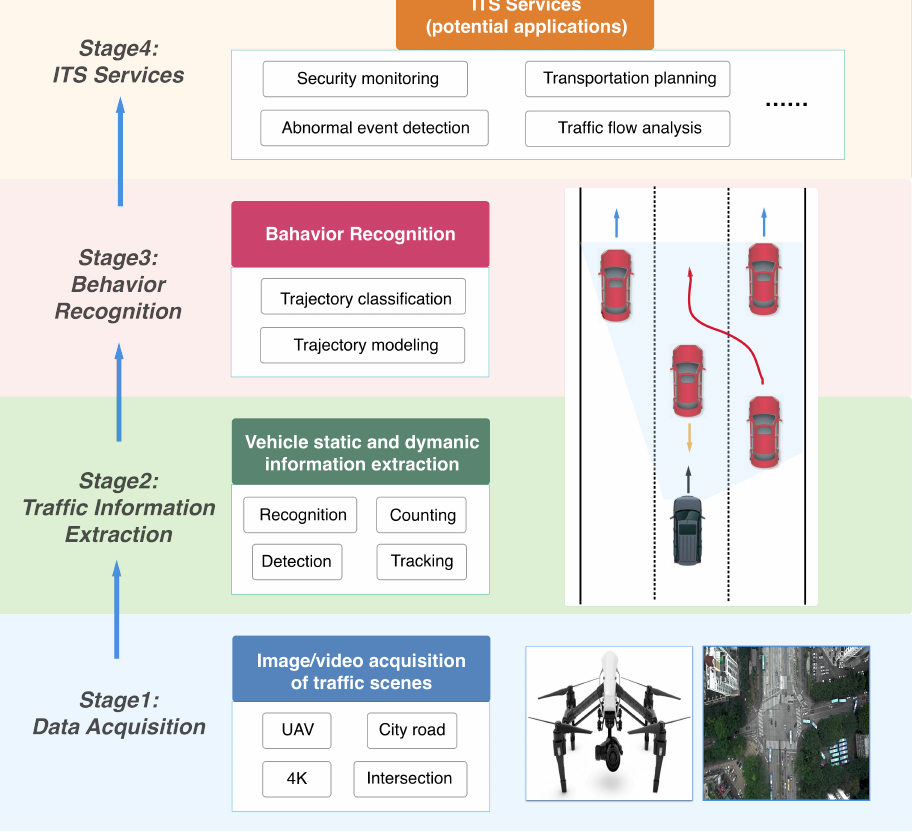
Figure 1. An illustration of the hierarchical structure of our work and its relationship to the intelligent transportation system (ITS). In the first stage, we used a UAV to collect high-resolution city traffic videos and, in Stage 2, extracted the static and dynamic information of road vehicles. In the third stage, we modeled and analyzed vehicle trajectory data, and observed vehicle behaviors. In our future work, all these achievements could contribute to the construction of comprehensive ITS services, such as traffic flow analysis, abnormal event detection, and security